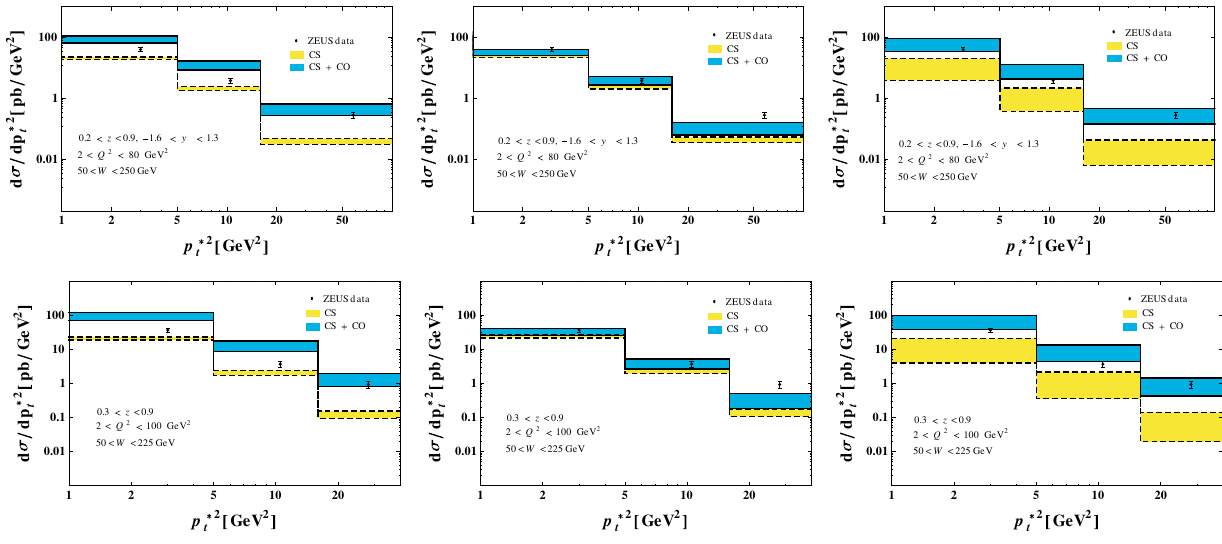
Fig. 3 The differential cross sections for the J /ψ production in DIS with respect to p (cid:11) 2 t . The experimental data are taken from Ref. [49]. The l.h.s., middle, and r.h.s. plots correspond to the LDMEs taken in Refs. [28,30,41], respectively